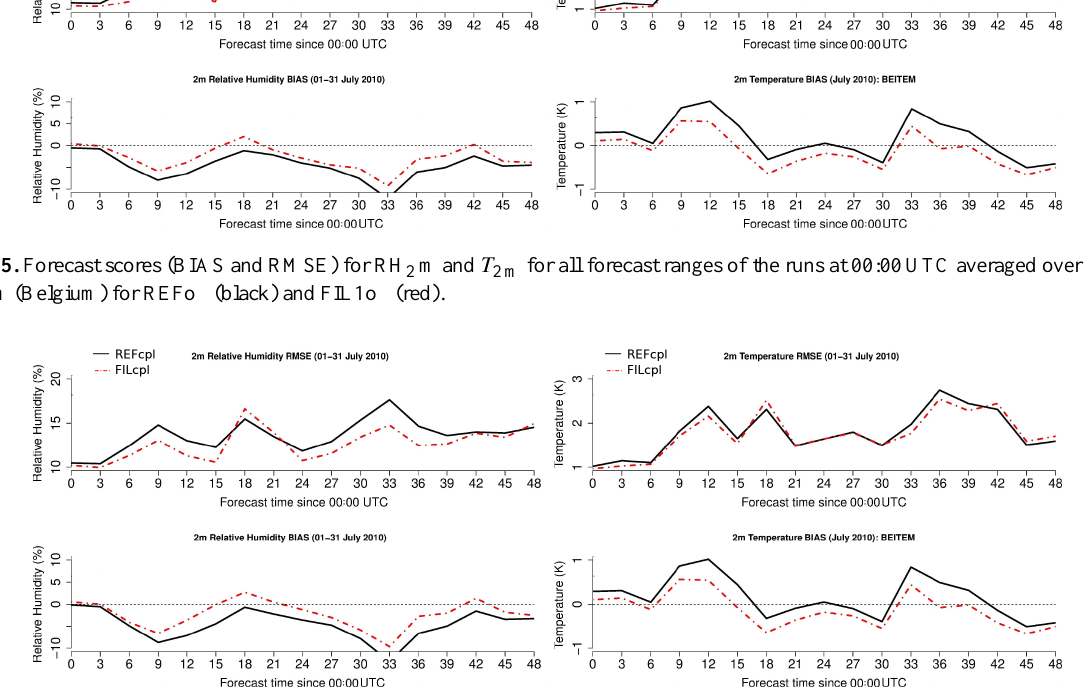
Figure 16. Forecast scores (BIAS and RMSE) for RH 2 m and T 2m for all forecast ranges of the runs at 00:00UTC averaged over July 2010 in Beitem (Belgium) for REFcpl (black) and FILcpl